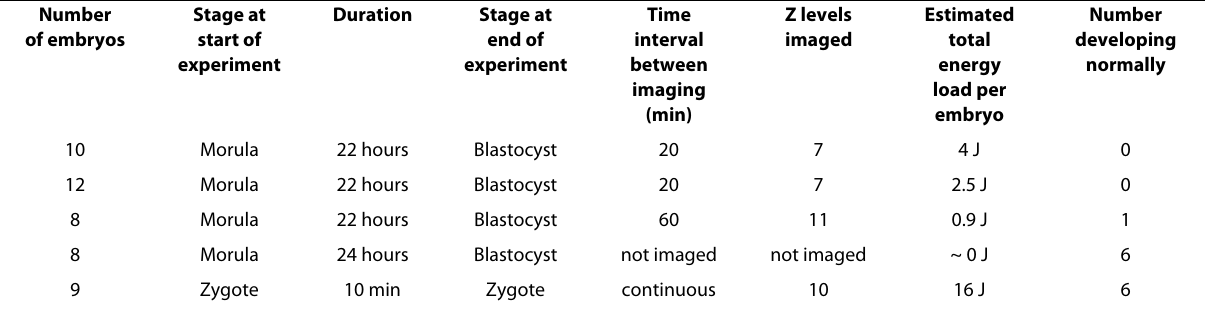
Table 1: Viability of embryos imaged with HGM Number of